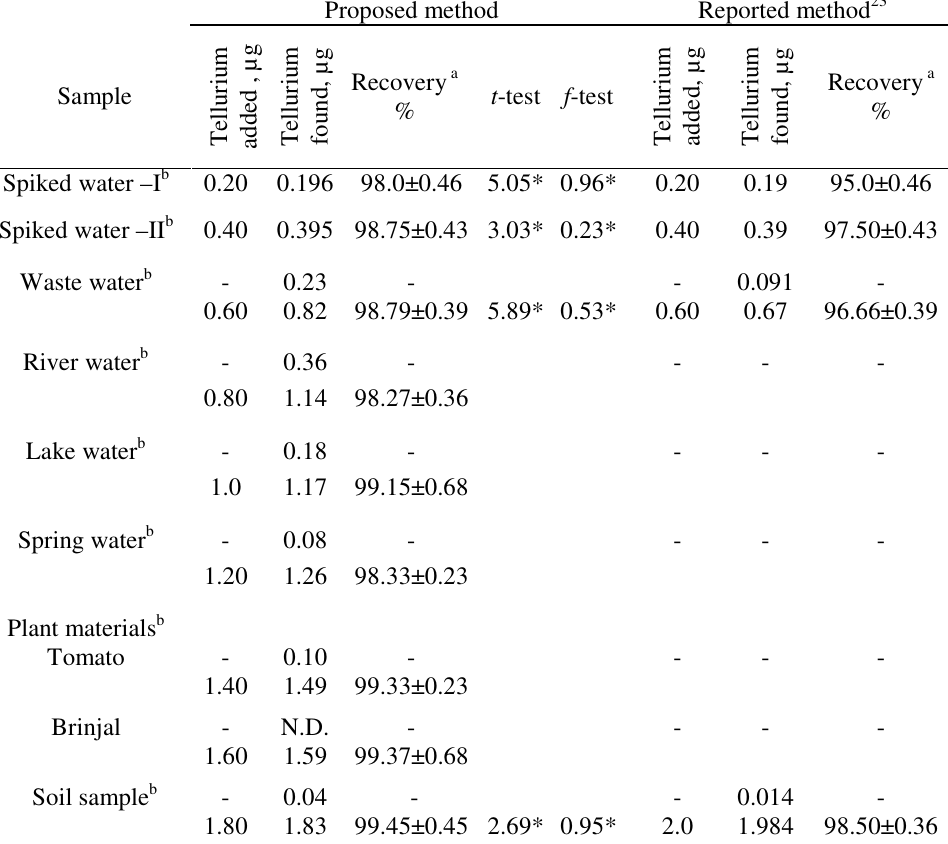
Table 3. Determination of traces of tellurium(IV) in various